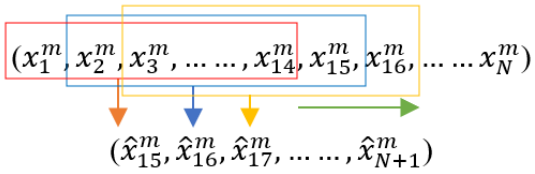
Figure 1. Passenger flow distribution. ( a ) Passenger flow distribution under time granularity , ( b ) Passenger flow distribution under time granularity , ( c ) Passenger flow distribution 𝛥𝛥𝛥𝛥 = under time granularity , ( d ) Passenger flow distribution under time granularity 1 𝛥𝛥𝛥𝛥 = 3 𝛥𝛥𝛥𝛥 = 5 𝛥𝛥𝛥𝛥 = 16. The actual passenger flow in the th period of day is recorded as , and the predicted passenger flow is recorded as . According to the 𝑛𝑛𝑚𝑚 𝑚𝑚 𝑛𝑛 𝑥𝑥 time-varying characteristics of passenger flow in Figure 1, for an O-D pair, the passenger 𝑛𝑛𝑚𝑚 𝑥𝑥� , 𝑛𝑛 = 1,2 … … 𝑁𝑁 , 𝑚𝑚 = 1,2,3, … same period of the 15th day, which means that are used to predict , as shown in Figure 2. 𝑛𝑛−14𝑚𝑚 𝑛𝑛−13𝑚𝑚 𝑛𝑛−1𝑚𝑚 𝑥𝑥 , 𝑥𝑥 , … , 𝑥𝑥 𝑛𝑛𝑚𝑚 𝑥𝑥�